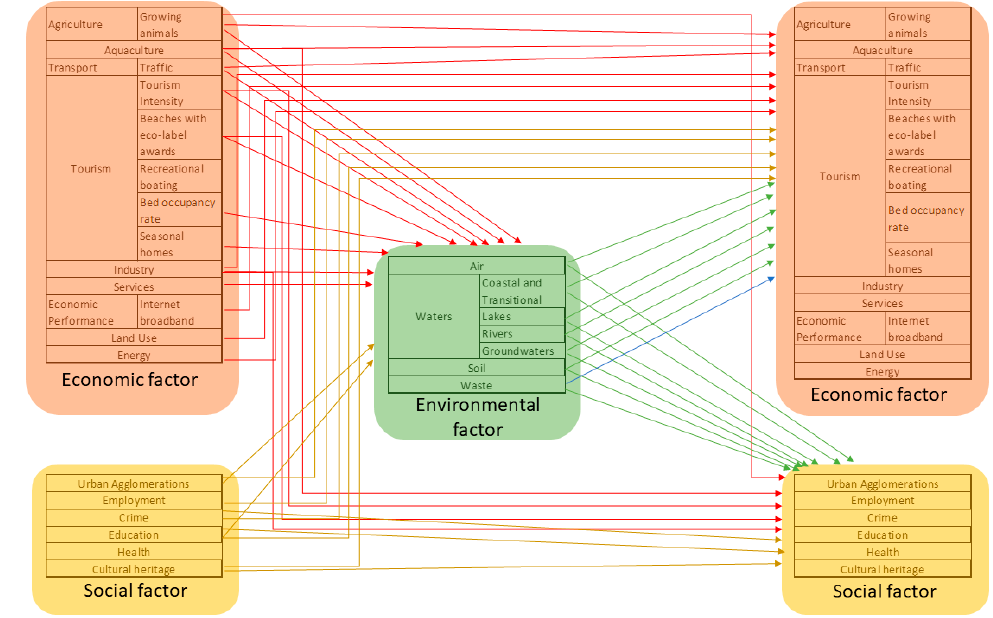
Figure 4. Interaction between the indicators proposed for analysis (authors).